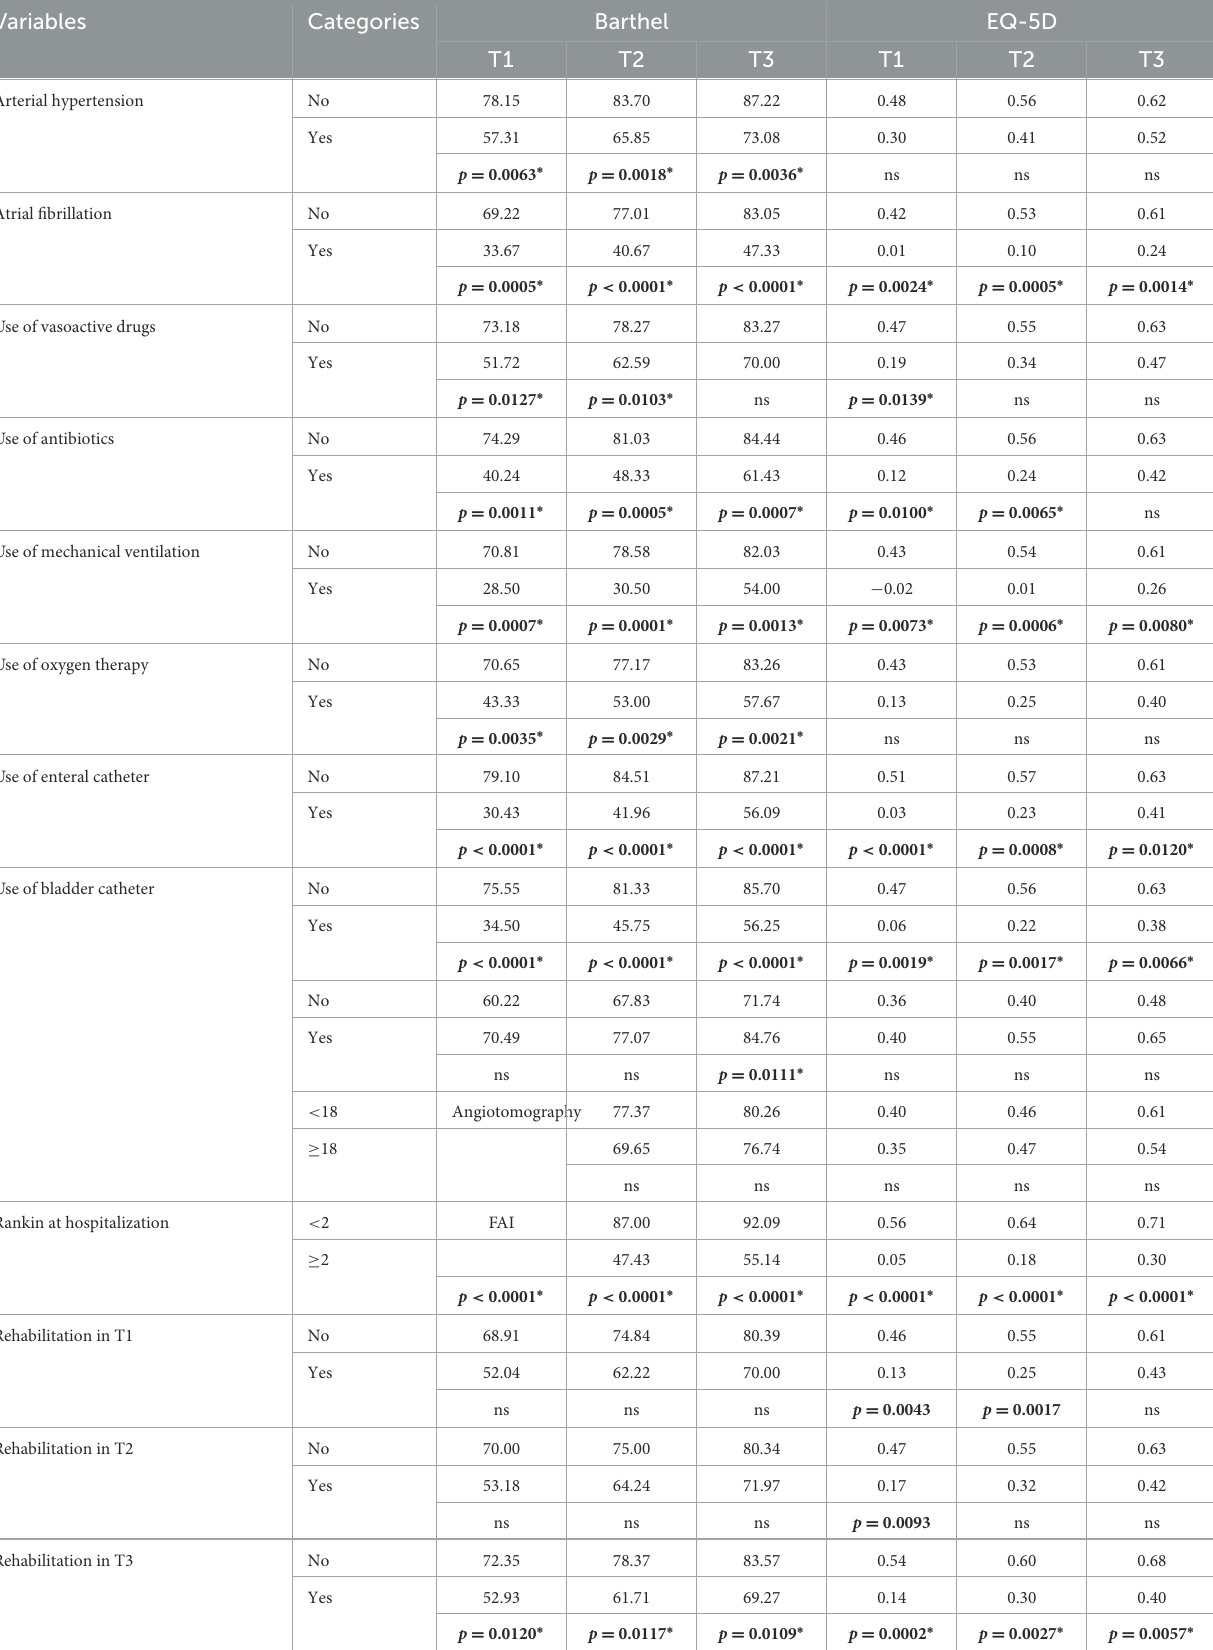
TABLE 3 Comparison of means of functionality and quality of